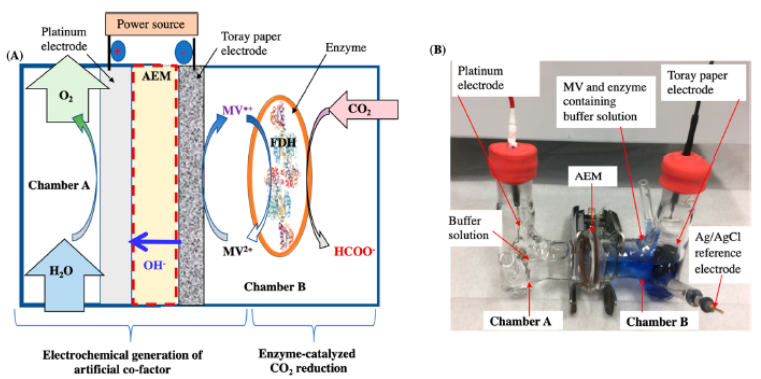
Figure 7. Coupled system for CO 2 reduction and artificial cofactor electrochemical regeneration. (A) Reactor configuration; (B) Experimental set-up. Adapted with permission from Ref [84]. Copyright © 2018 American Chemical Society.